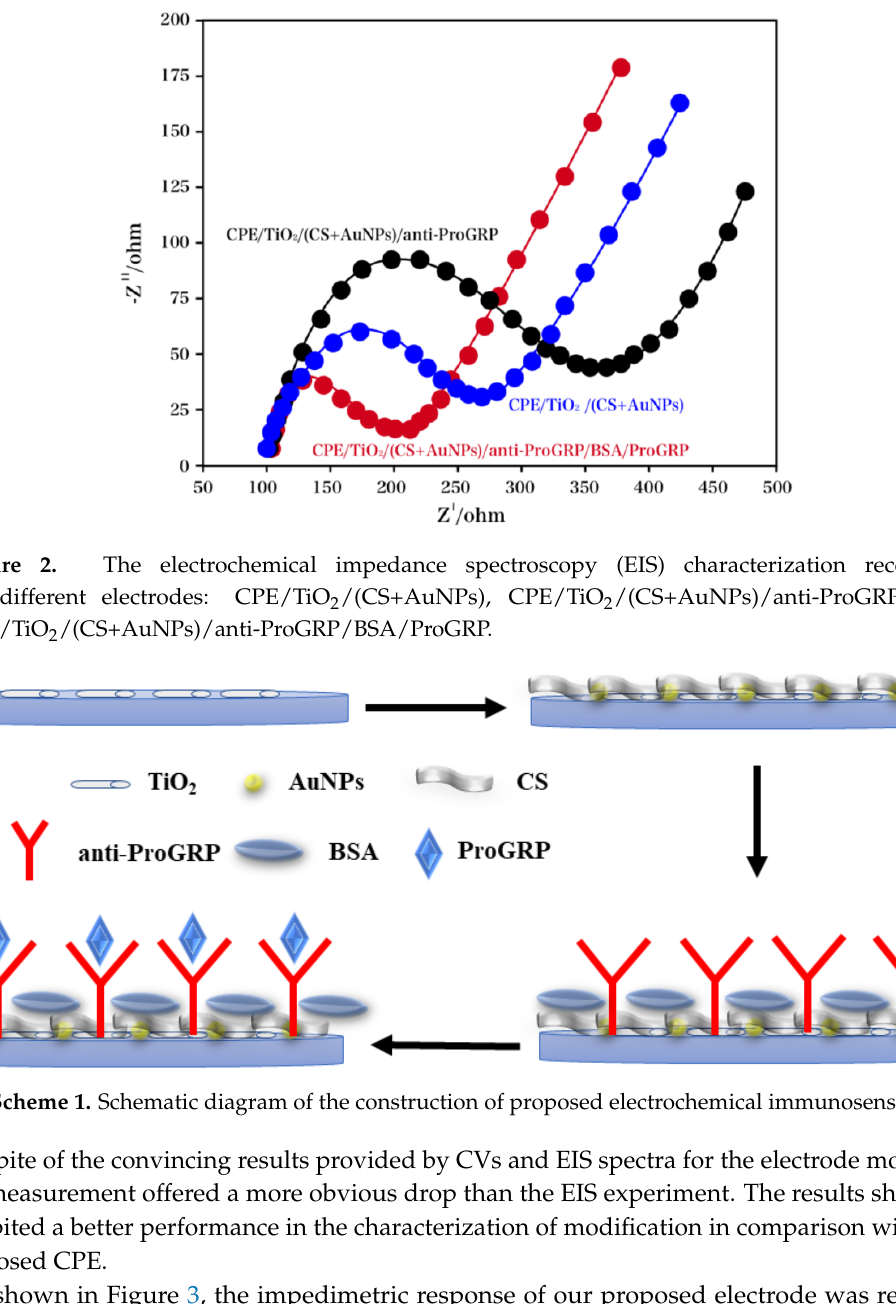
Scheme 1. Schematic diagram of the construction of proposed electrochemical immunosensor.